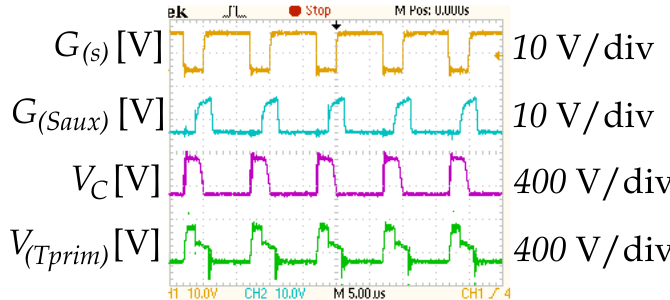
Figure 10. Waveforms of the resonant part of the tandem converter.